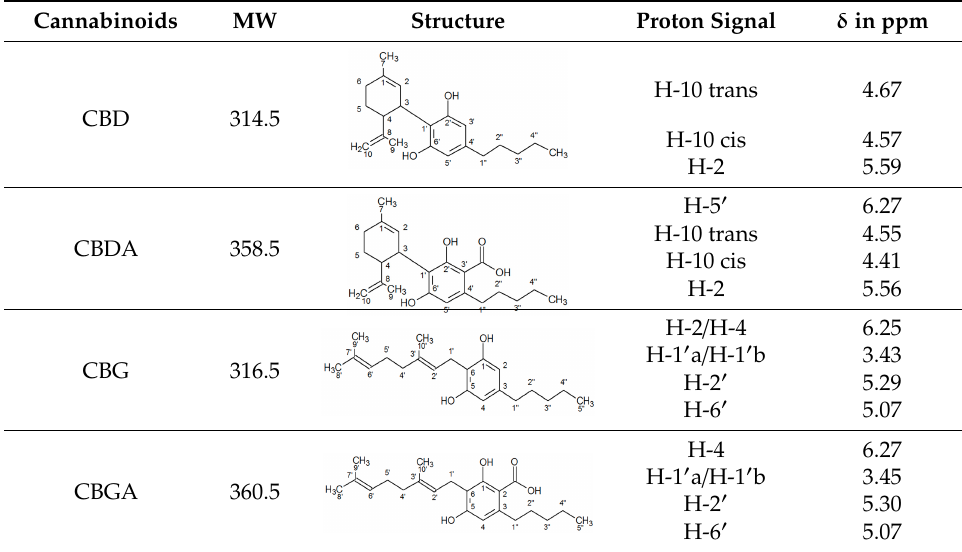
Table 4. Molecular weight, structure and selected signals (ppm) of cannabinoids.